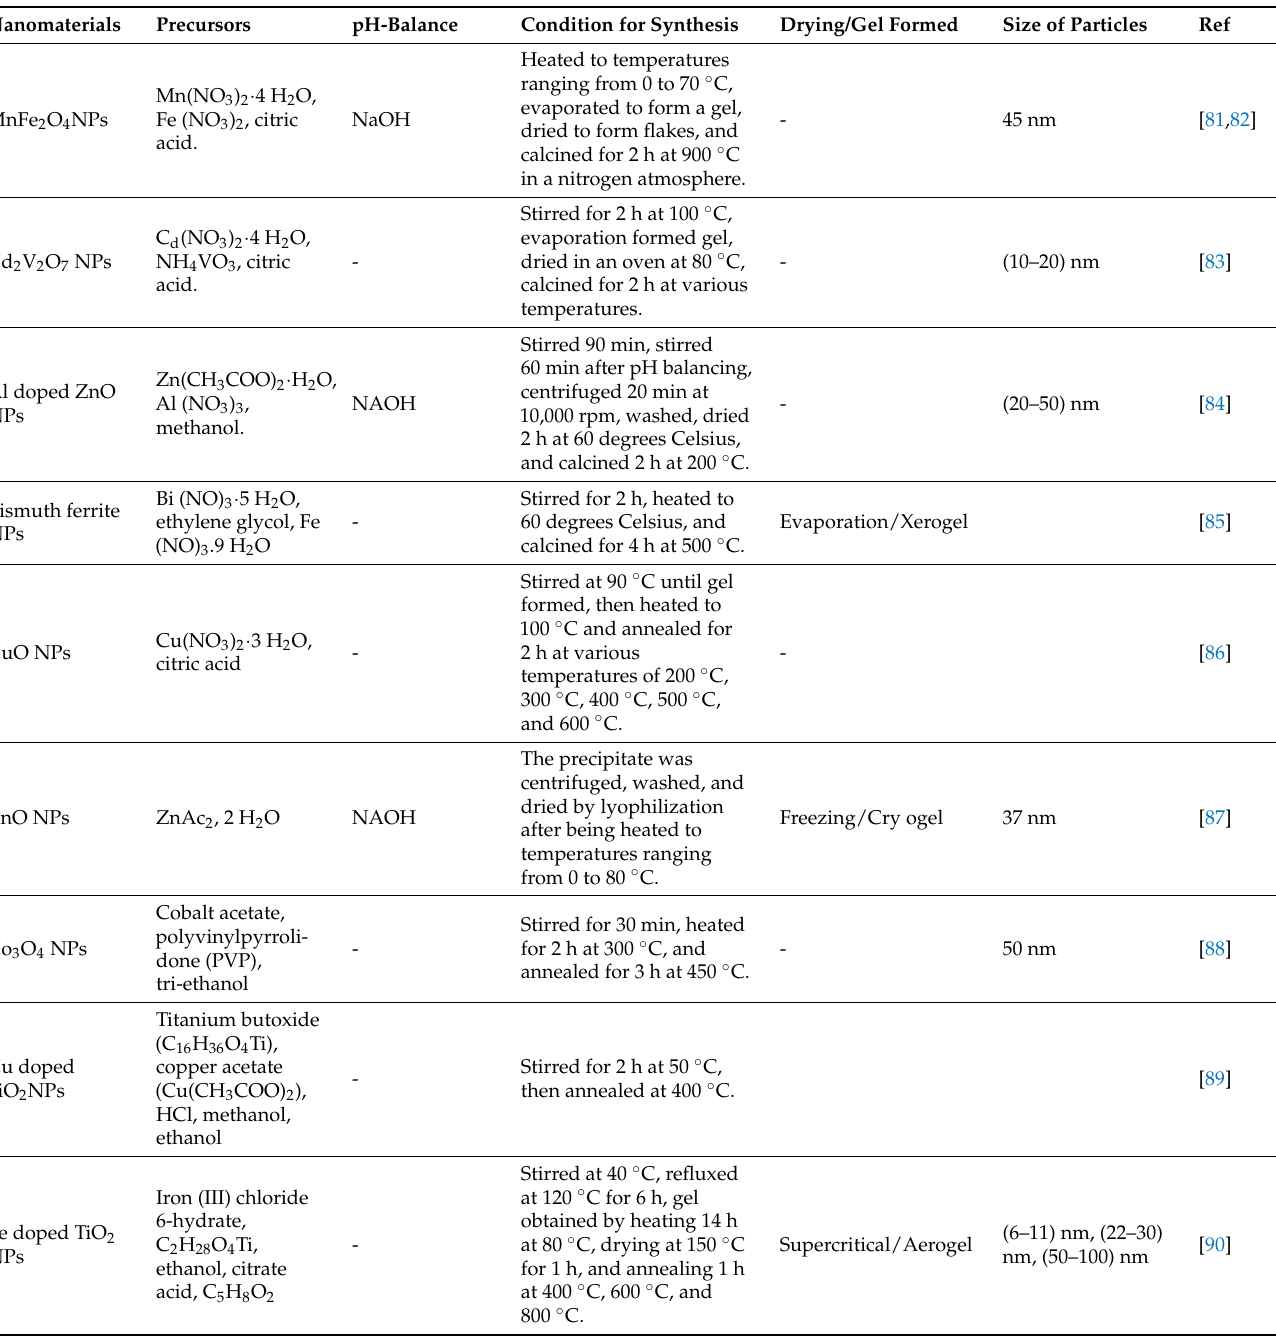
Table 2. Summary of various synthetic approaches involved in the sol-gel